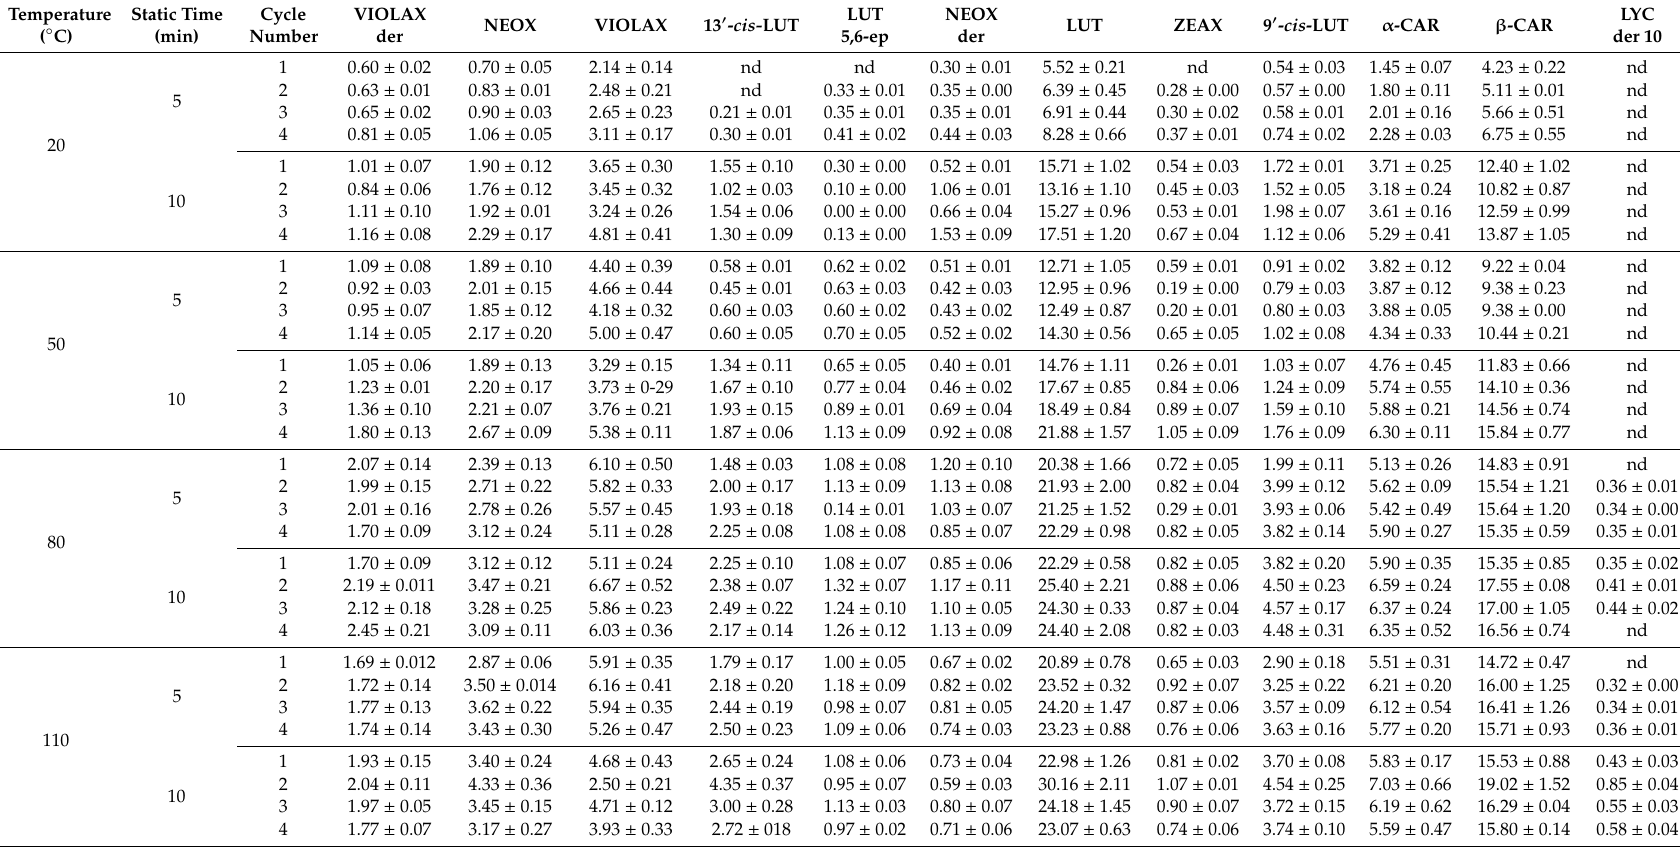
Table 5. Nettle leaves carotenoids (mg 100 g − 1 dm) in extracts obtained at ASE di ff erent